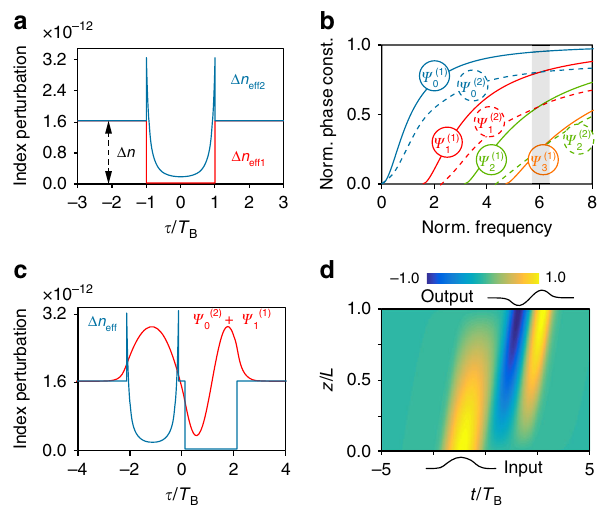
Fig. 4 Supersymmetric TWGs and TPLs. a Temporal index perturbations Δ n Δ n T = 660 ps, | Δ β = 10 − 3 ps·m − 1 , eff1 and eff2 of a step-index TWG (2 B 1 | β = 0.06 ps 2 ·m − 1 ) and its T-SUSY partner. b Normalised dispersion 2 diagram b – ν of the temporal bound states ψ 1 ð Þ n and ψ 2 ð Þ n of both TWGs, where b is the normalised phase constant, de fi ned for each n -th order mode = ð 2 Δ ββ as b n : ¼ 1 (cid:2) K n = Δ β (cid:2) Δ β 2 , and ν is the normalised frequency, with 2 Þ 1 ν 2 : ¼ 2 T 2 Δ β = β (here, ν = 6). ψ 2 ð Þ n exhibits a lower slope (is less 2 B dispersive) than ψ n + 1 (1) . The grey area is the phase-matching bandwidth, the interval Δ ν where Δ b ≤ 0.2 between SUSY bound states. c Index perturbation of a TPL (blue) constructed from two T-SUSY TWGs with a time separation T B /4 (2 T B = 660 ps), and its temporal supermode (red), generated from the perfect phase-matching between the states ψ 2 ð Þ and 0 ψ 1 ð Þ . d Pulse-shape transformation resulting from the energy transfer 1 between ψ 2 ð Þ and ψ 1 ð Þ in the TPL (Supplementary Movie 1 0 (fundamental mode) of β B1 (Fig. 4a, Supplementary Note 4). From T-SUSY theory, both TWGs have the same energy spectrum.